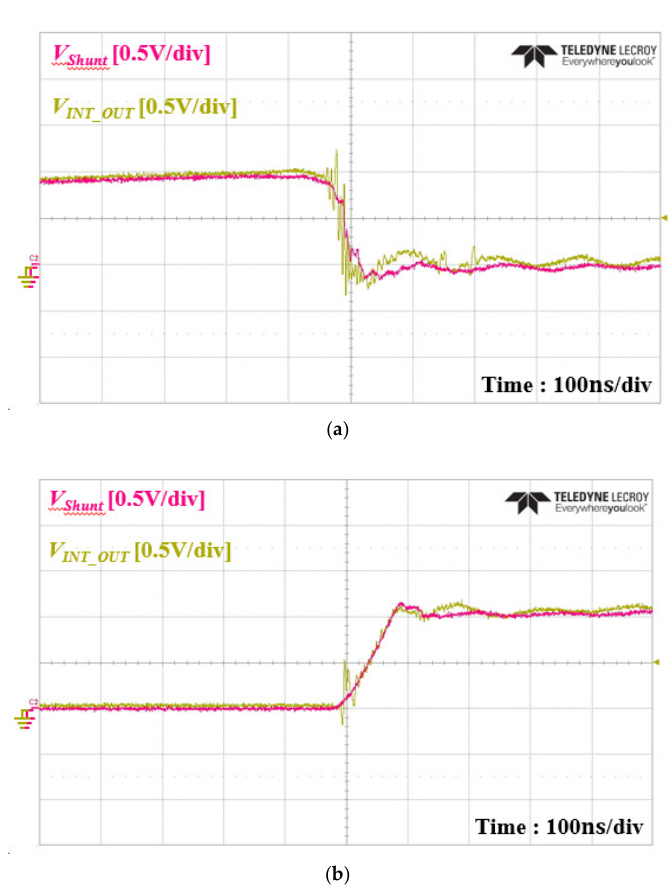
Figure 17. Transient DPT waveform of a shunt resistor and a spiral pick-up coil: ( a ) turn-off; ( b ) turn- on.